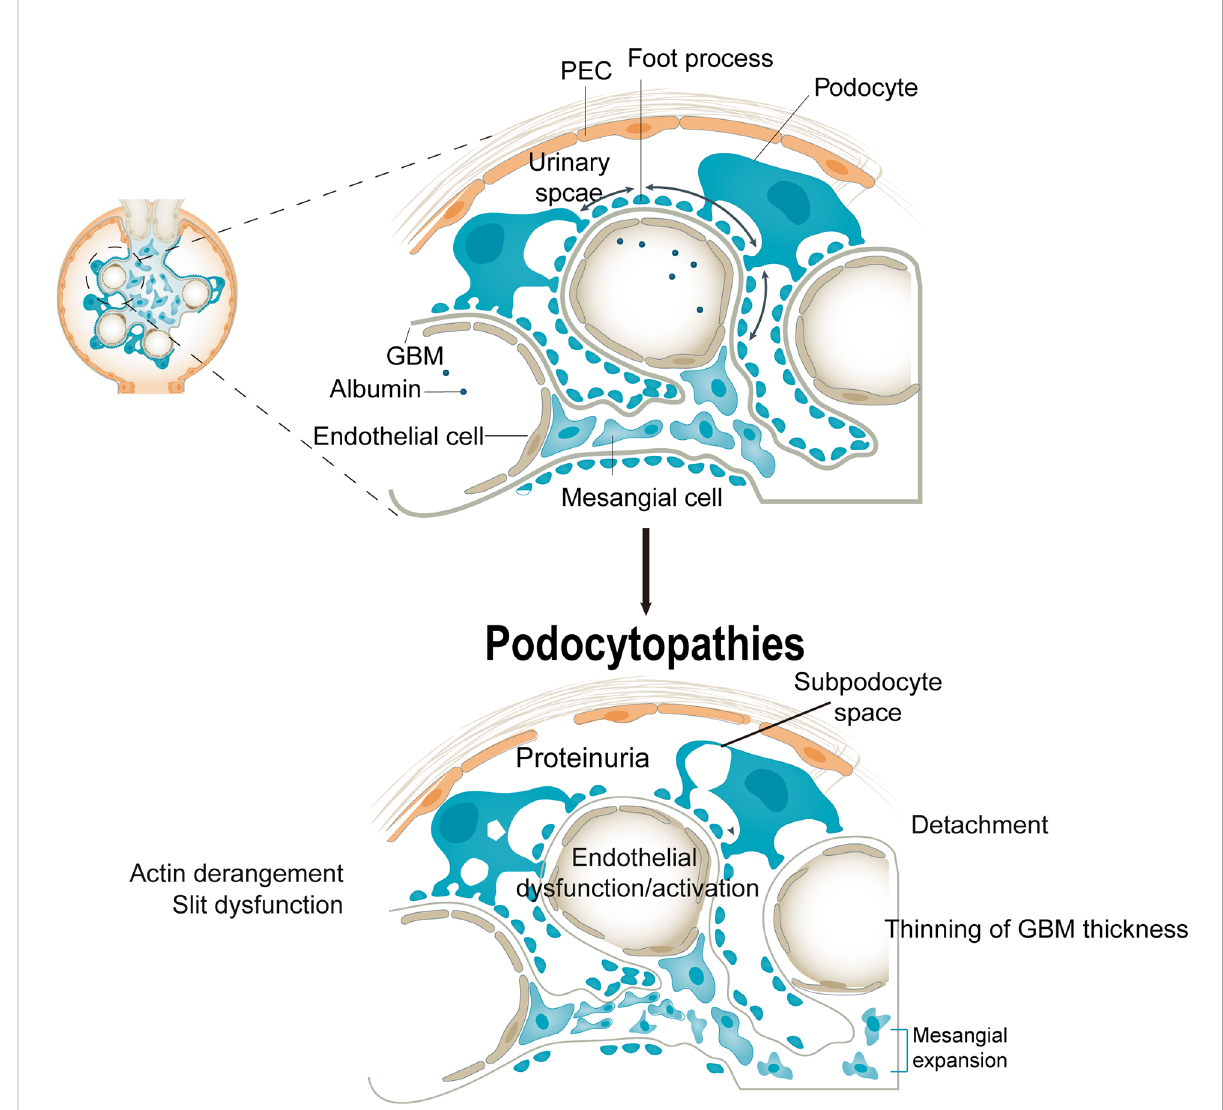
FIGURE 1 Consequences of podocytopathies. Podocyte injury causes cellular and structural responses in the glomerulus. An injured podocyte has cytoplasmic blebs, protein droplets, and an expanded subpodocyte space. Foot process effacement is associated with actin derangement, which induces dysfunction of slit molecules. The injured podocyte detaches from the glomerular basement membrane, which is associated with abnormalities of adhesion molecules, coagulation cascade, chemokine receptor expression, and lipid peroxidation. These changes may depend on podocyte detachment but also on aberrant factors from injured podocytes. PECs, parietal epithelial cells; VEGF, vascular endothelial growth